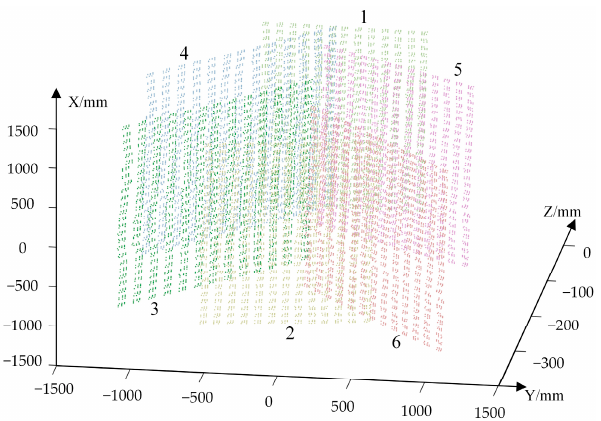
Figure 11. The coded points on the calibration target in six positions in G-CS.